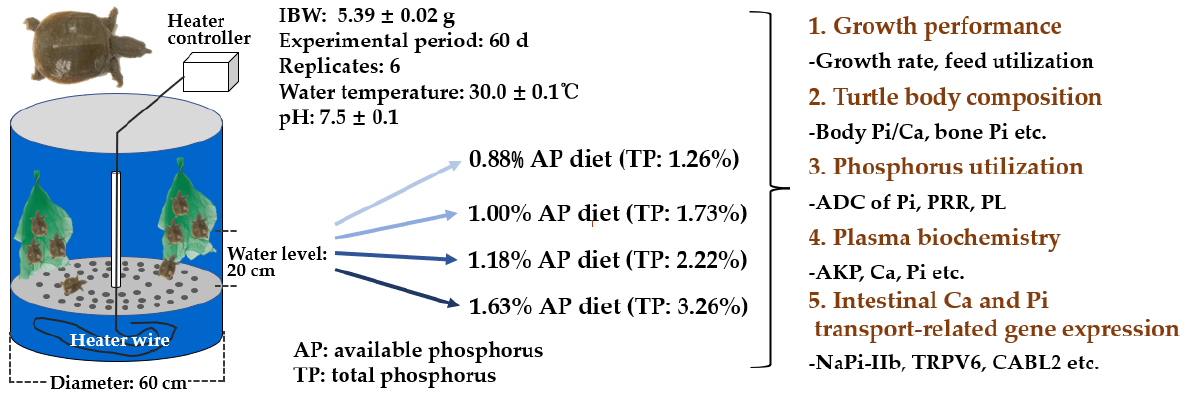
Figure 1. Flow chart of the experimental design.